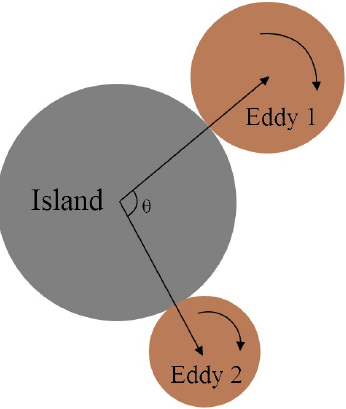
Figure 12. Sketch illustrating the position relationship of the two split eddies. When the eddy (eddy 1) encounters the island, the sec- ondary eddy (eddy 2) splits-off at angle θ during the splitting.